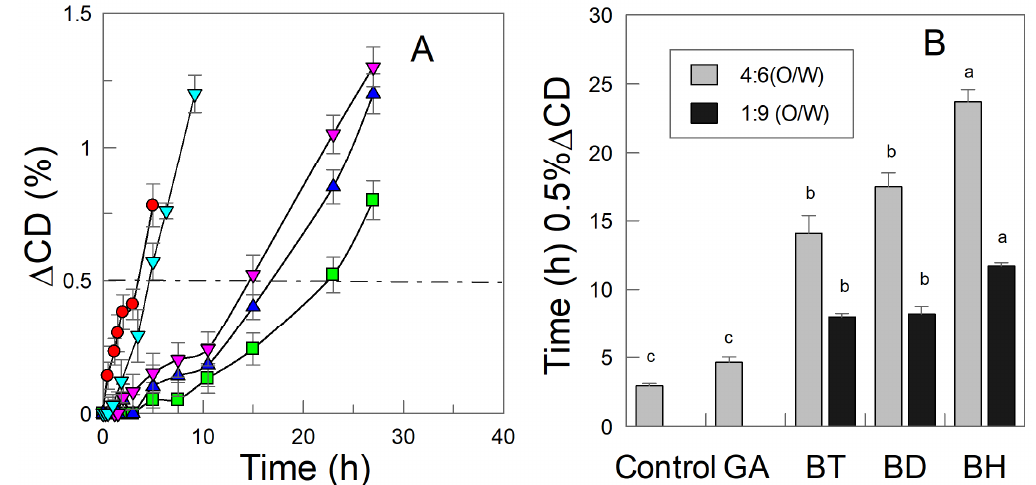
Figure 1. ( A ) Oxidative stability in terms of the variation in CD formation in 4:6 (O / W) stripped fish oil-in-water emulsions in the presence of extracts from di ff erent Bryophyllum species ( (cid:4) - BH, (cid:78) - BD and (cid:72) - BT, TPC = 500 µ M GAE) and (cid:72) - GA ( 500 µ M) at T = 25 ◦ C, Φ = 6.68%. Control (- • -) samples did not contain any antioxidants. The dashed line marks the hours required for a 0.5%- increase in CDs. ( B ) E ff ect of di ff erent Bryophyllum extracts on the time required to increase CDs content to 0.5% at two di ff erent O / W ratios: 1:9 and 4:6. Data were expressed as average ± standard deviation and di ff erent letters indicate significant di ff erences ( α = 0.001).